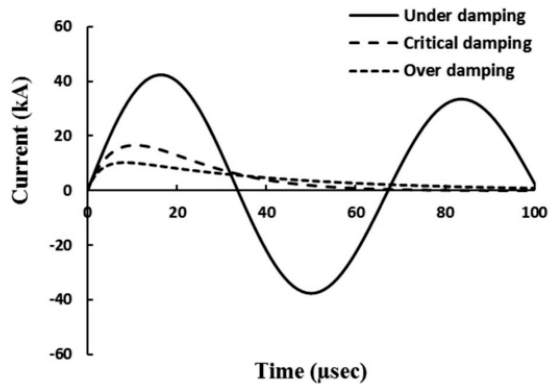
Figure 7. Typical current waveform for the cases of under-damped, critically-damped and over damped intensity functions in EDC process. Reprinted with permission from ref. [29] Copyright 2020 Taylor & Francis.